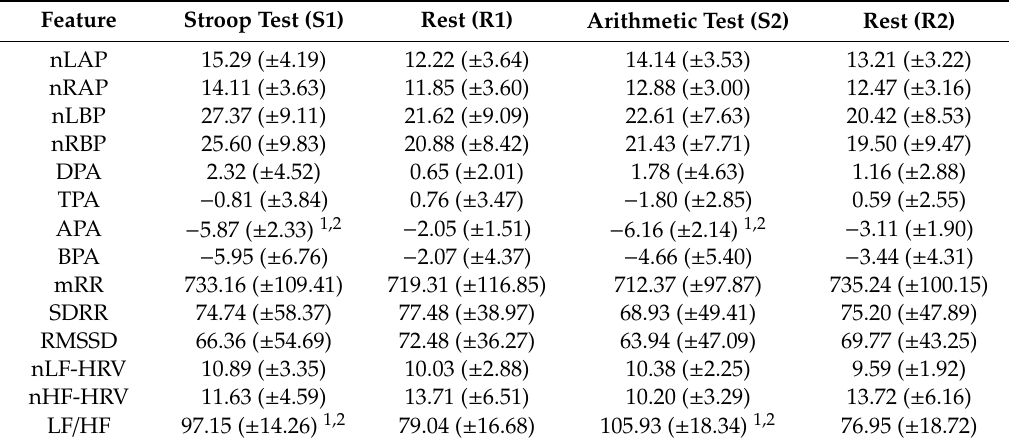
Table 2. E ff ects of the Stroop test and the mental arithmetic test on the EEG and HRV features.